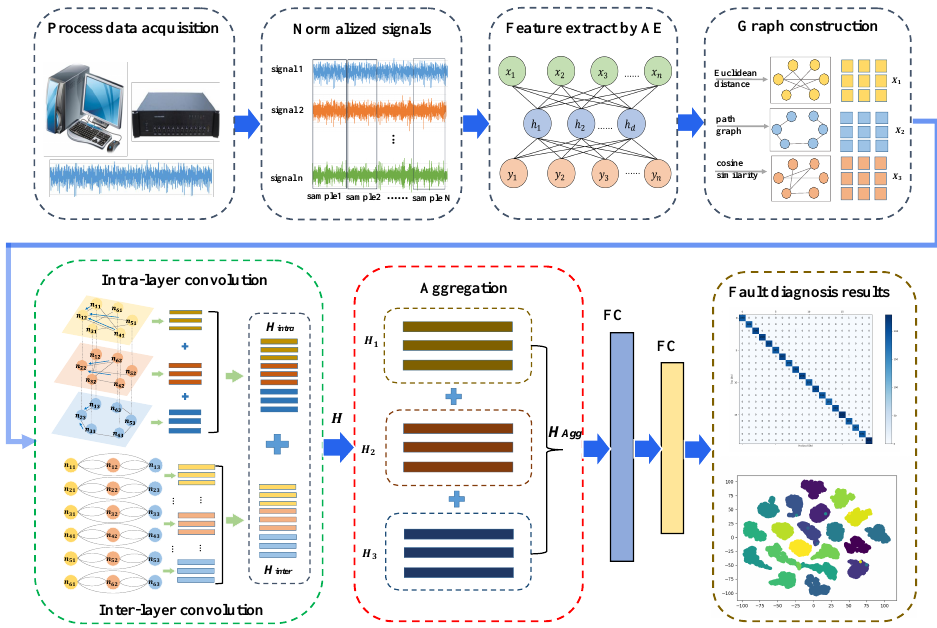
Figure 2. Flow chart of AE-MSGCN fault diagnosis